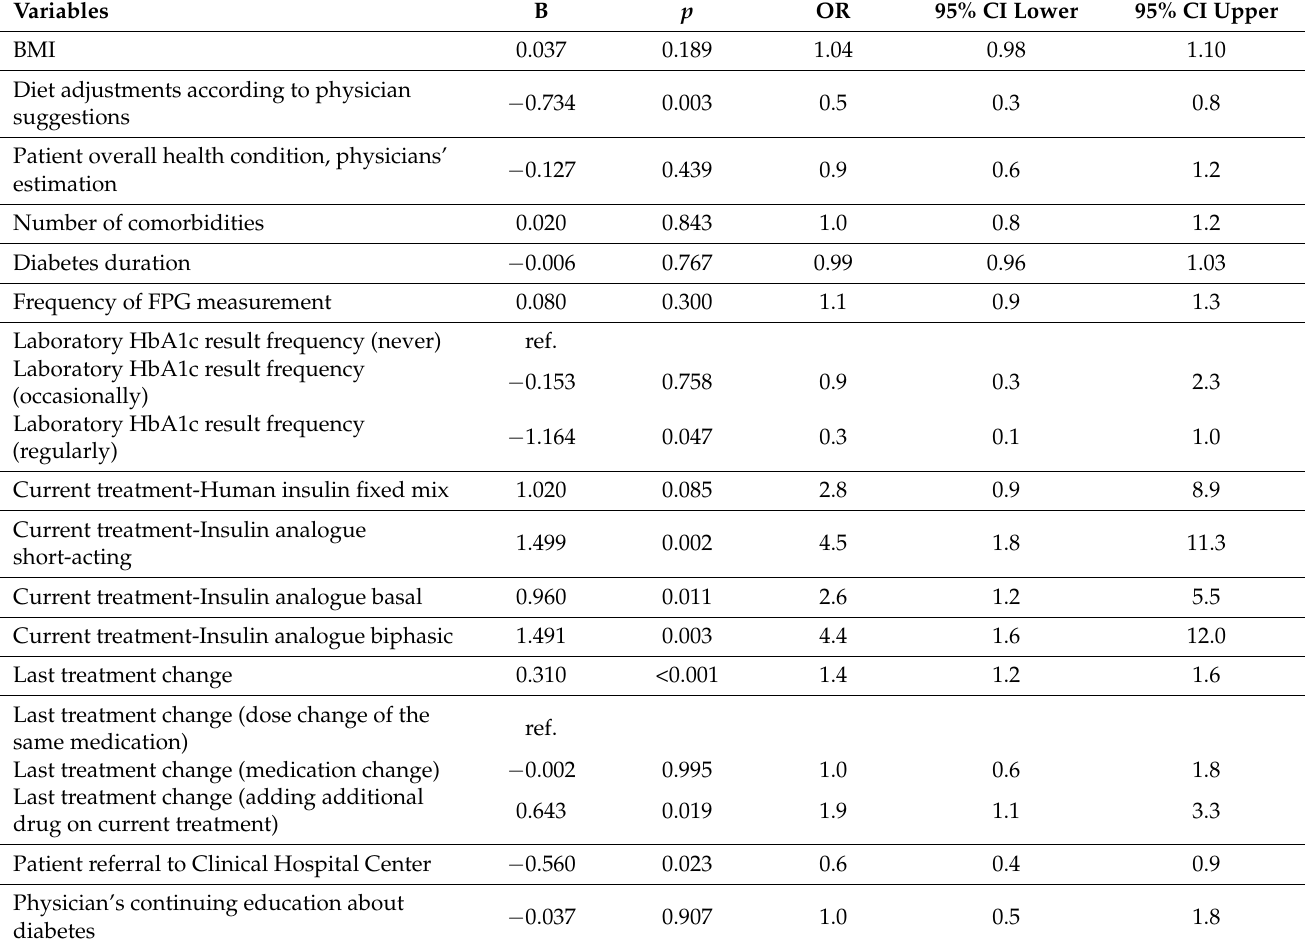
Table 6. Predictors of clinical inertia in of type 2 diabetes